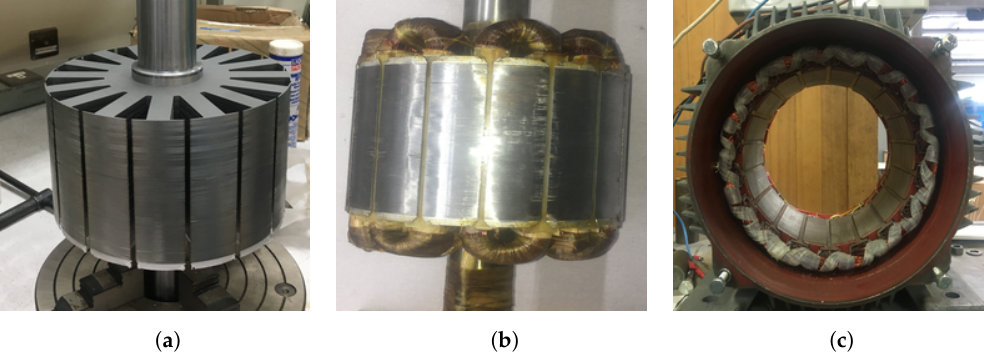
Figure 22. Photos of the manufactured prototype of the 4.2 kW 16/18 pole/slot WRSG. ( a ) Optimized rotor stack assembly, ( b ) optimized rotor winding, and ( c ) complete stator winding in its frame.